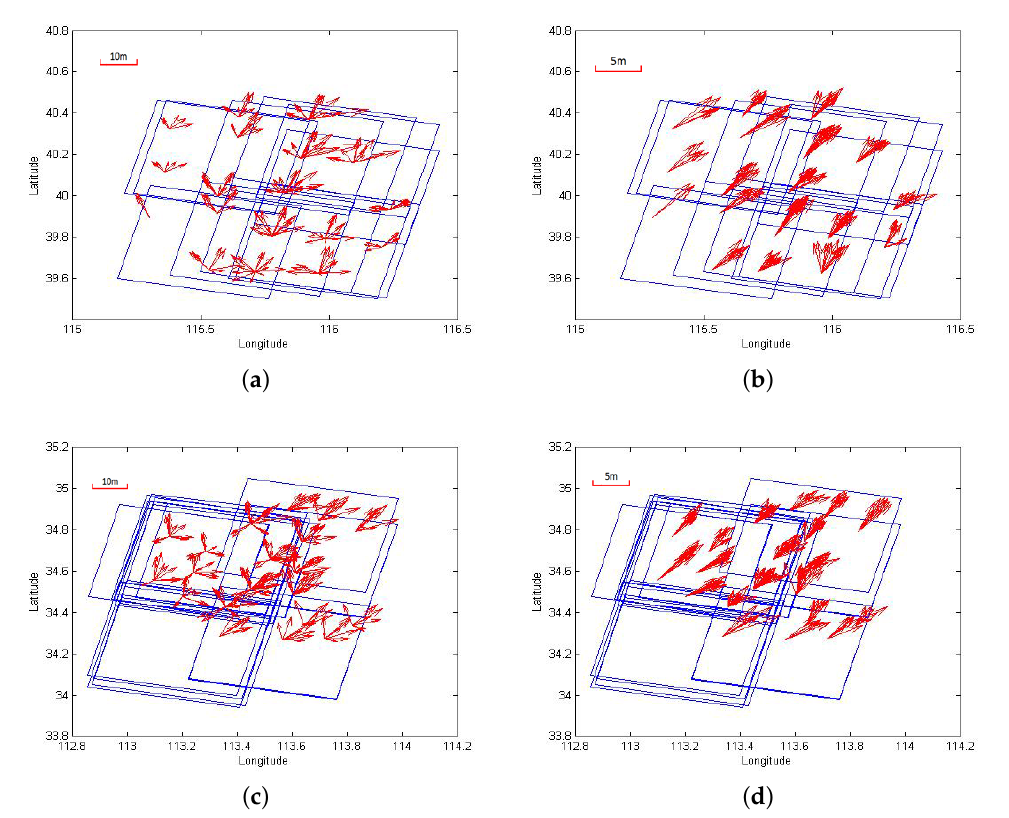
Figure 7. Comparison of error distribution of each check point set of ( a , b ) Beijing and ( c , d ) Songshan area. ( a , c ) Represent the original error distribution, while ( b , d ) represent the residual error distribution after block adjustment.